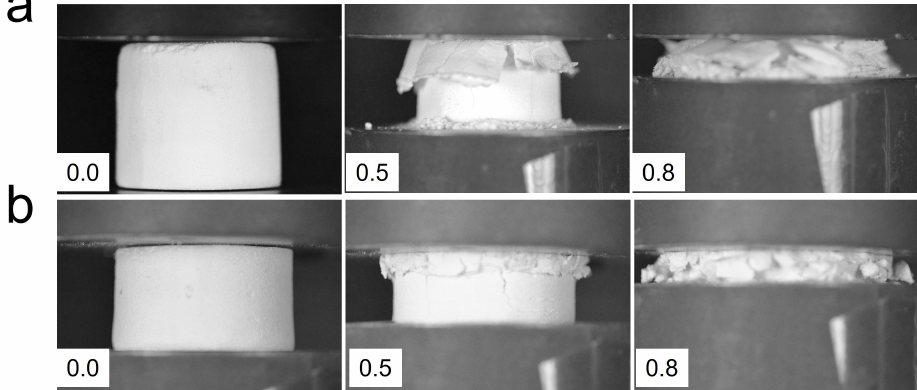
Figure 6. Images of compression testing of ( a ) sintered bilayer foam GF3/GF4 and ( b ) GF3 uniform foam. The numbers in inset are